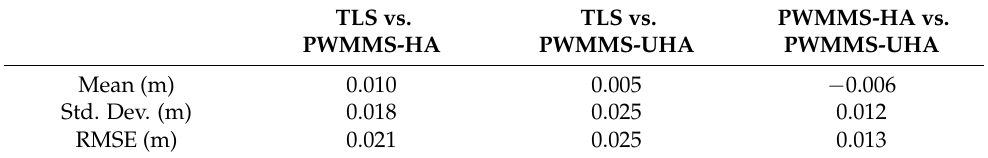
Table 4. Statistics of the difference between bridge deck thickness estimates from different